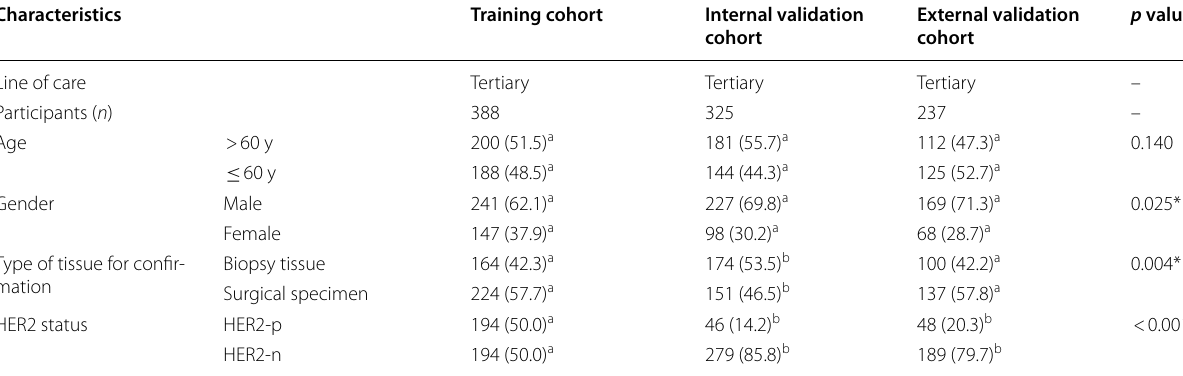
Values are the number (percentage) unless otherwise indicated. HER2-p a,b pairwise comparison results. There was no difference between cohorts given consistent letters, while there was a statistically significant difference between cohorts given inconsistent letters